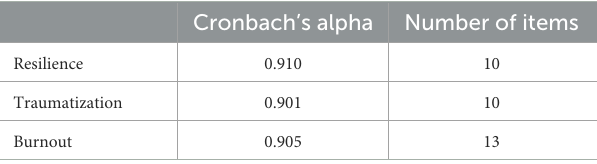
TABLE 2 Cronbach alpha for resilience, traumatization, and